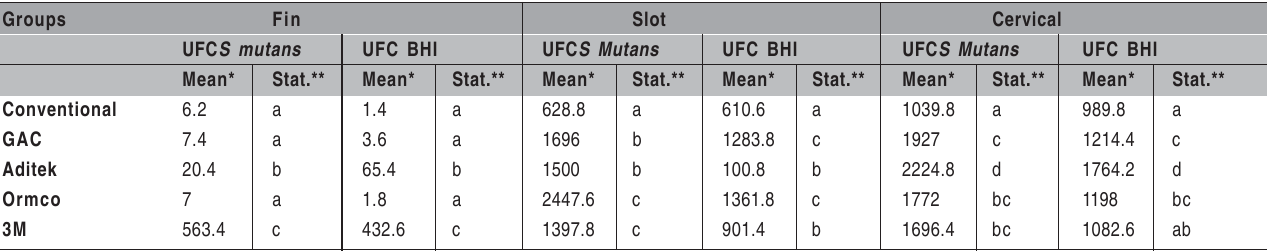
Table 2 - Mean colony forming unit values and statistical analysis for the different groups of